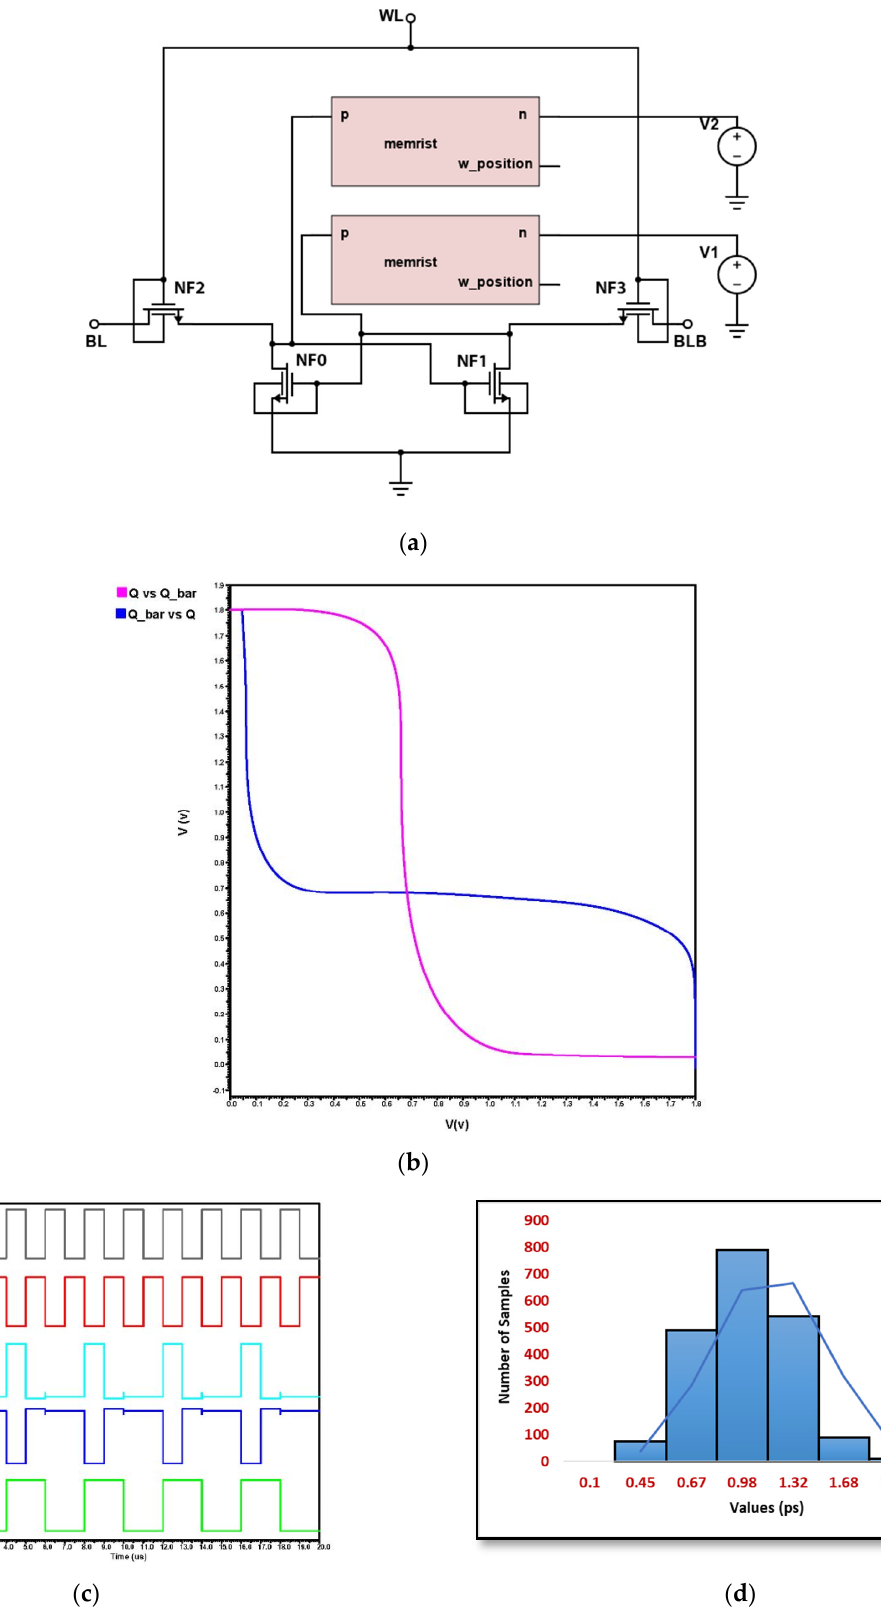
Figure 12. Proposed hybrid FinFET and Ti/SiO 2 /Si(n++)/TiN Memristor 6T-SRAM ( a ) Schematic, ( b ) DC Analysis, ( c ) Transient Analysis, and ( d ) Monte Carlo